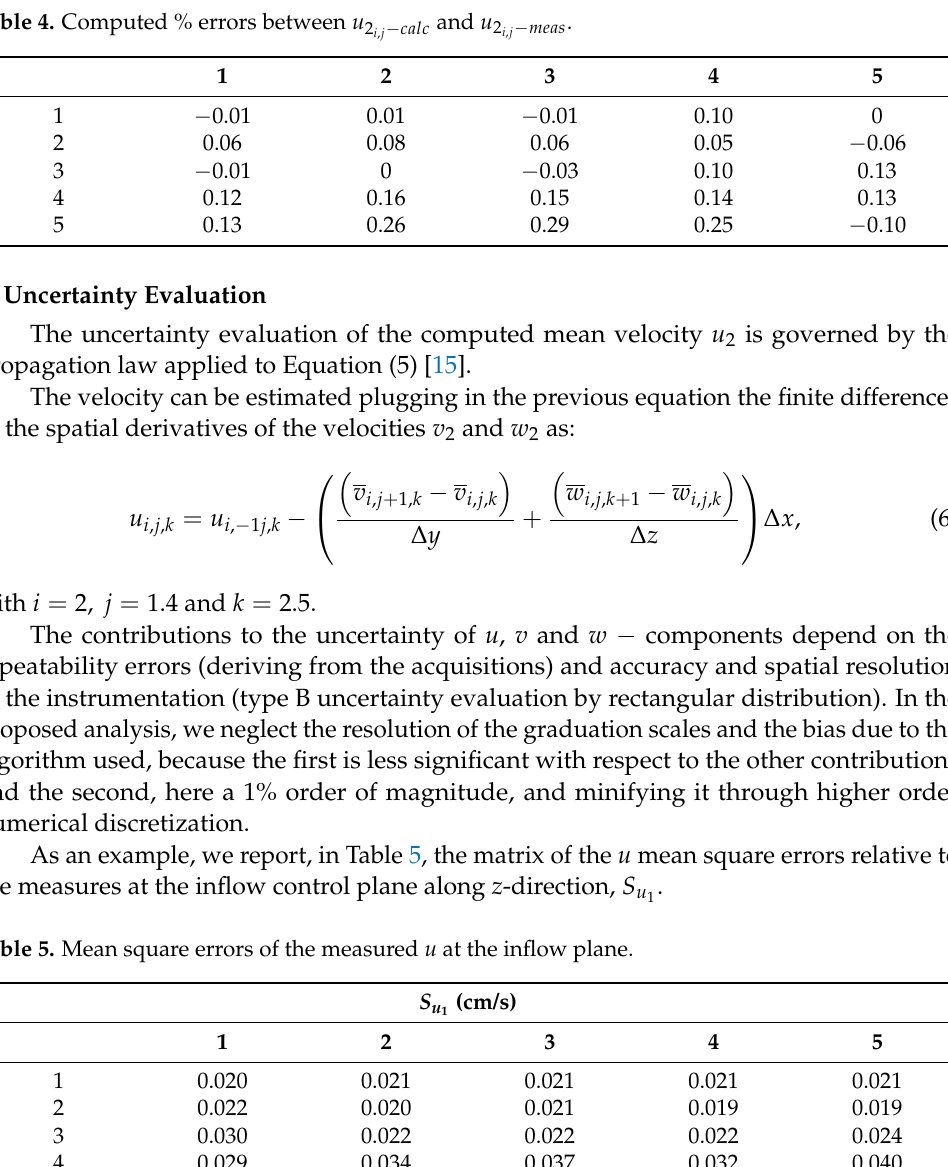
and u 2 . i , j − meas i , j − calc